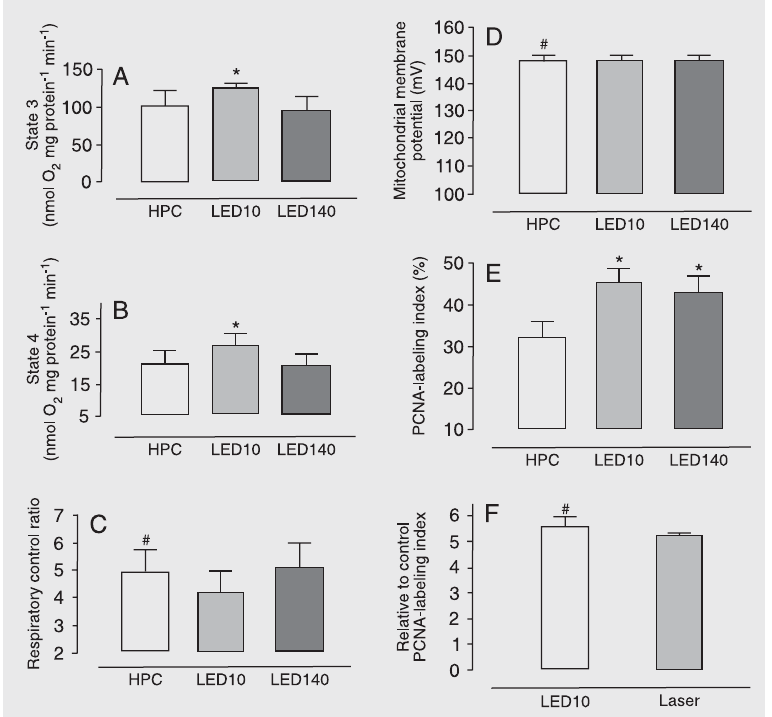
Figure 1. Effect of light-emitting diode (LED) and laser light irradiation on rats with partial hepatectomy. All panels contain data for control, LED 10 J/cm 2 (LED10) and LED 140 J/cm 2 (LED140), except panel F which compares LED10 and laser. Each group consisted of 7 rats in each group. A , Mitochondrial state 3. *P < 0.05 for LED10 vs LED140 or hepatectomy control (HPC). B , Mitochondrial state 4. *P < 0.05 for LED10 vs LED140 or HPC. C , Respiratory control ratio. # P > 0.05 for HPC vs LED10 and LED140. D , Mitochondrial membrane potential. # P > 0.05 for HPC vs LED10 and LED140. E , Proliferating cell nuclear antigen (PCNA)-labeling index. Comparison of HPC vs LED10 and LED140. *P < 0.05 for LED10 and LED140 vs HPC. Statistical comparisons were carried out with ANOVA fol- lowed by the Bonferroni post-test. F , Values of the PCNA-labeling index (relative to control PCNA-labeling index - data normalized to the dose) for the LED10 and laser (15 J/cm²) groups. # P > 0.05 for LED10 vs